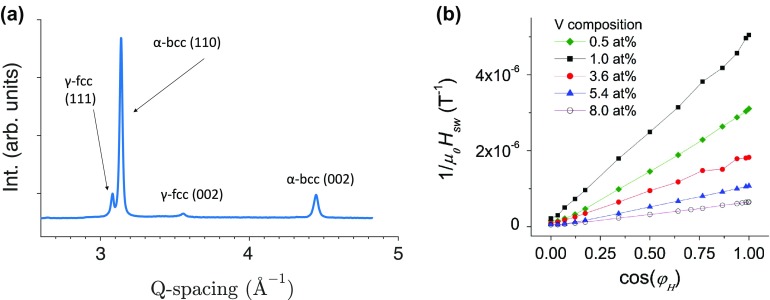
(a) Plot showing the experimental angular dependence of switching field for an Fe51Co41V8 sample in black dots and a fit with the Kondorsky model in red. (b) Angular dependence of the inverse switching field for compositions from 0.5 at% V to 8 at% V with nominally equal concentrations of Fe and Co. Inset of (a) shows the XRD pattern of the same sample as the given angular dependent switching field data.